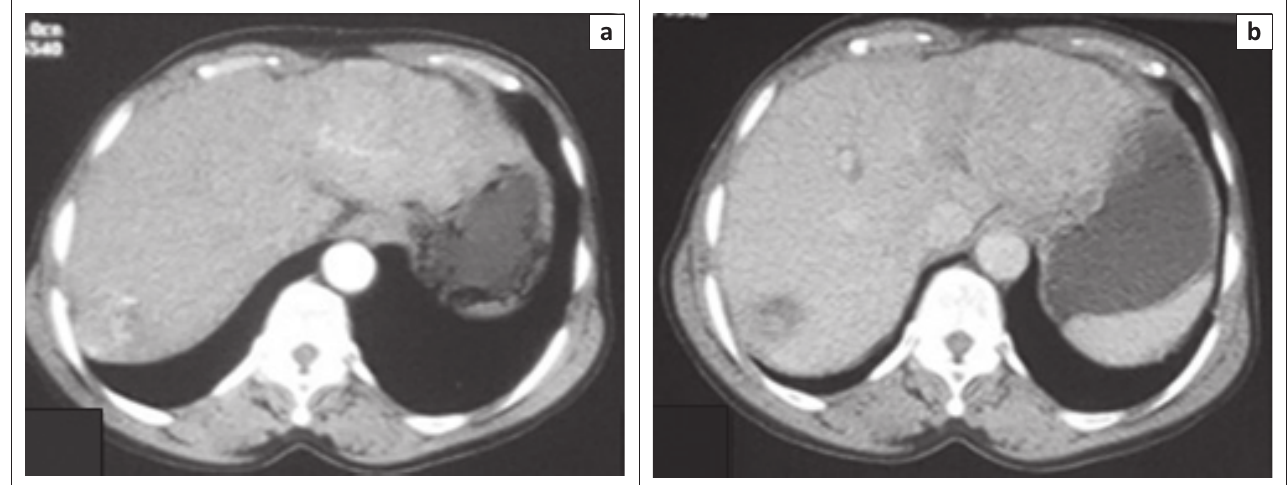
FIGURE 4: A 54-year-old male with hepatocellular carcinoma in segment VII of the liver who presented with right upper-quadrant pain. Axial computed tomography scans showing: (a) arterial phase enhancement and (b) rapid washout in the portovenous phase. TABLE 2: Liver Imaging Reporting and Data System categories of the 61 liver lesions. LI-RADS Number of category lesions